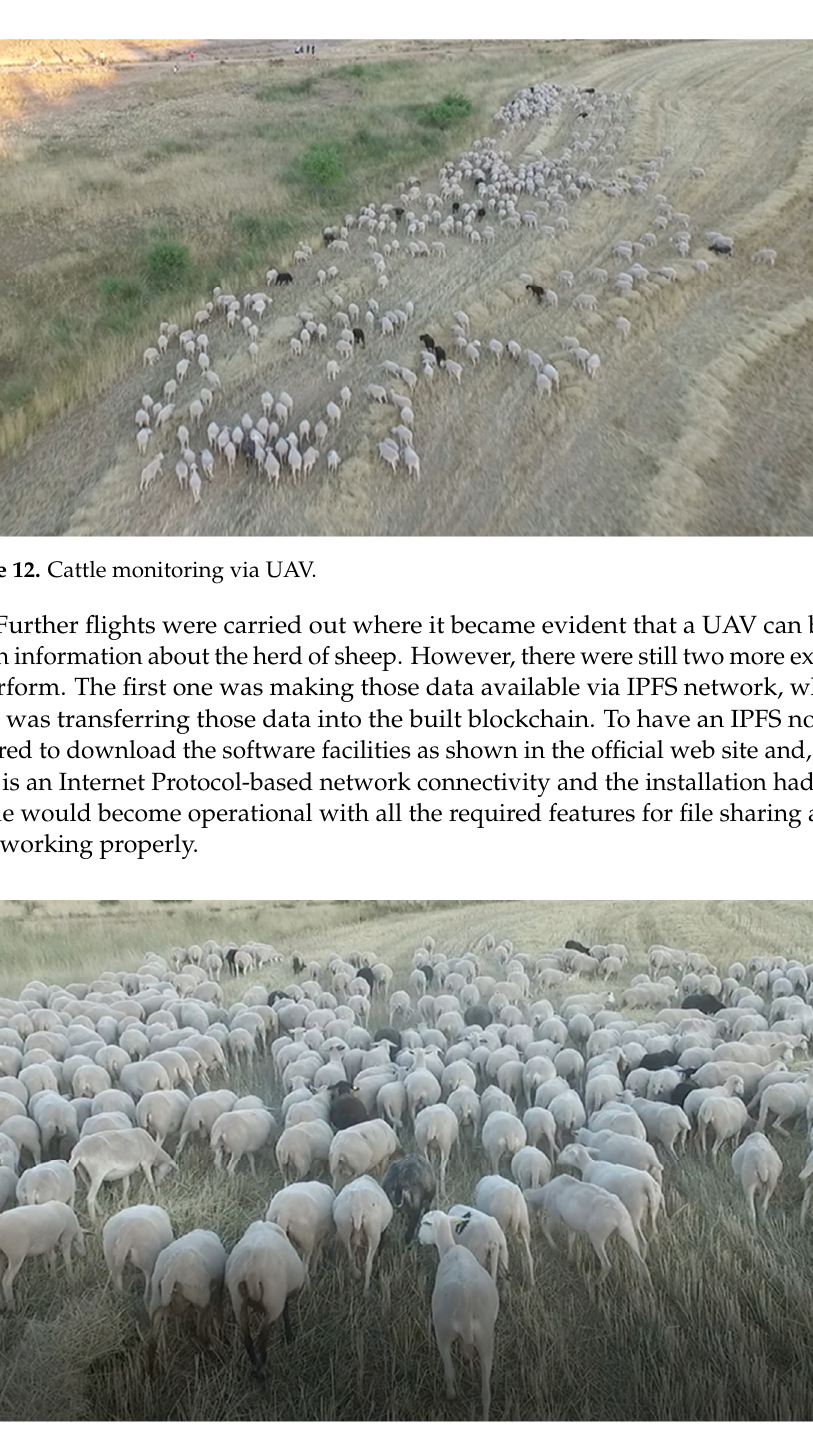
Figure 13. Close view of the sheep herd .